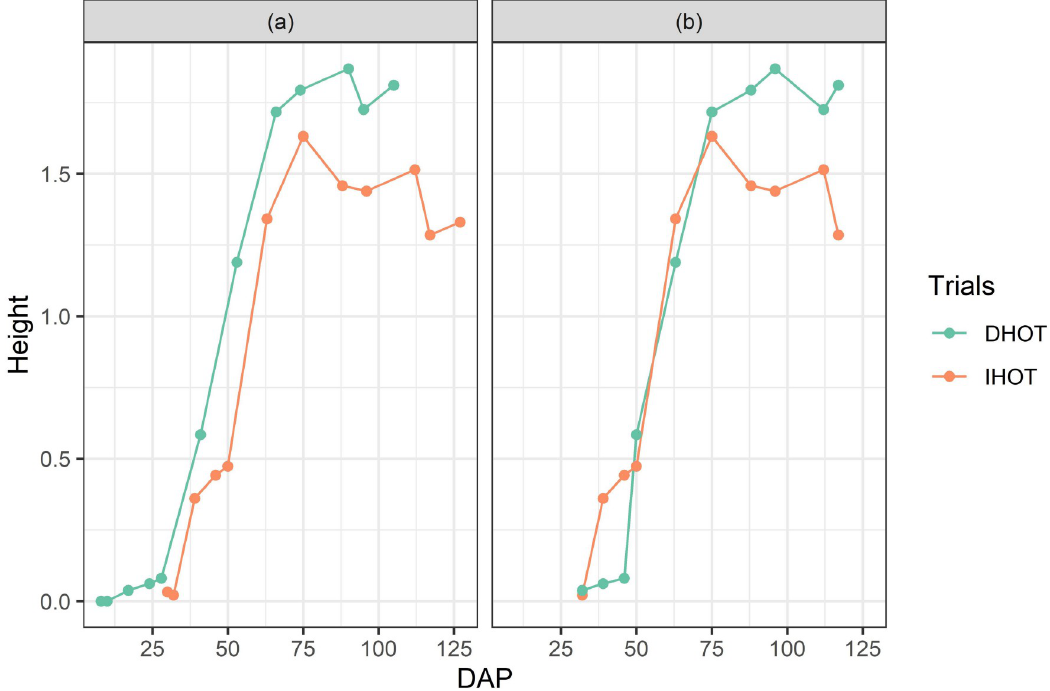
Fig 1. Average crop heights, per trial. (a) Before adjustments, and (b) after adjustments, of UAS observation dates, for re- alignments of crop growth stages at two trials. The Y-axes show the average height per trial, whereas the X-axes show the day after planting (DAP) as of IHOT